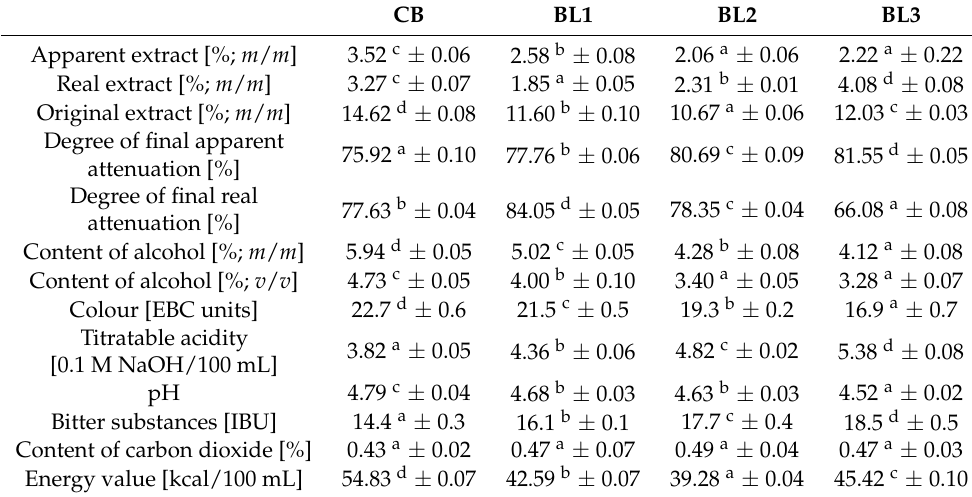
Table 1. Results of the physicochemical analysis of wheat beers with lemongrass